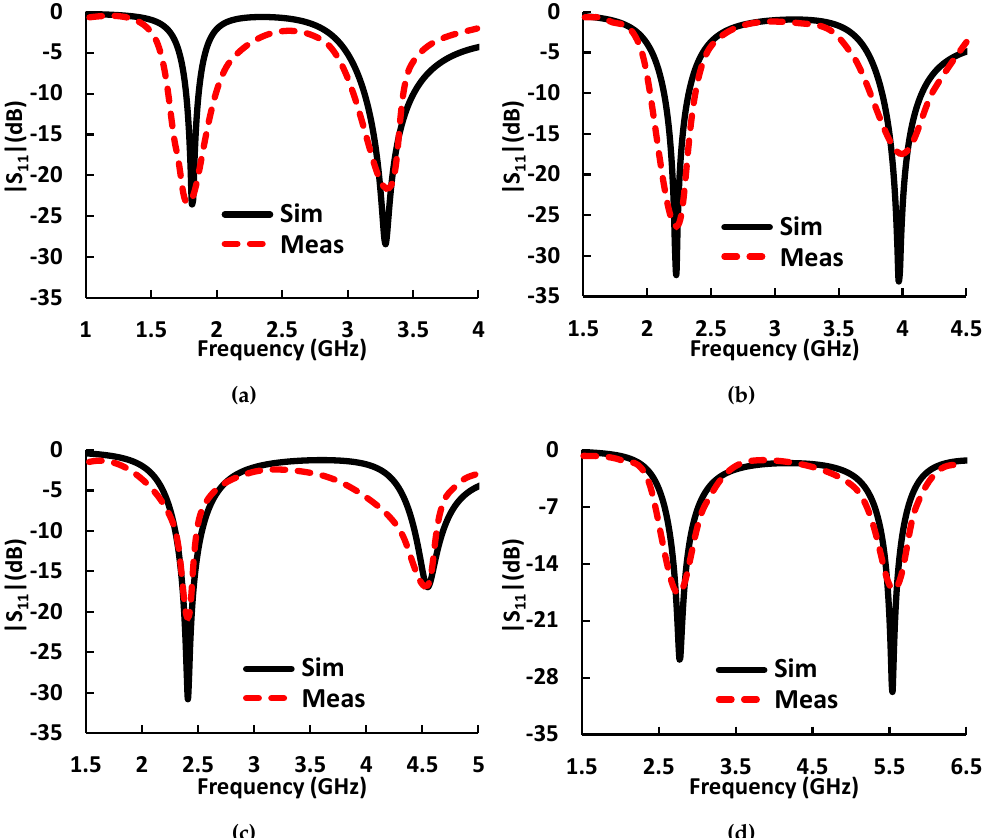
Figure 3. Simulated (Sim) and measured (Meas) reflection coefficient of the antenna: ( a ) Mode 1; ( b ) Mode 2; ( c ) Mode 3; and ( d ) Mode